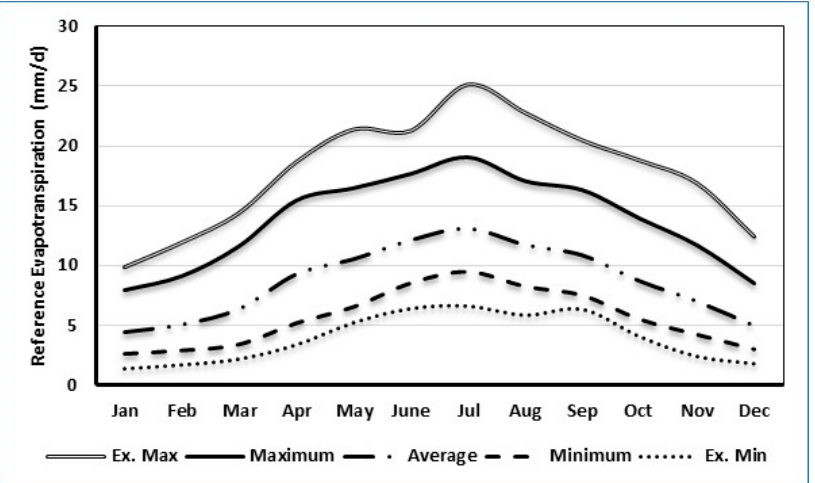
Figure 4. Five-year average of daily temperatures of the experimental farm collected from the weather station (Ex. Max = extreme maximum, Ex. Min = extreme minimum).